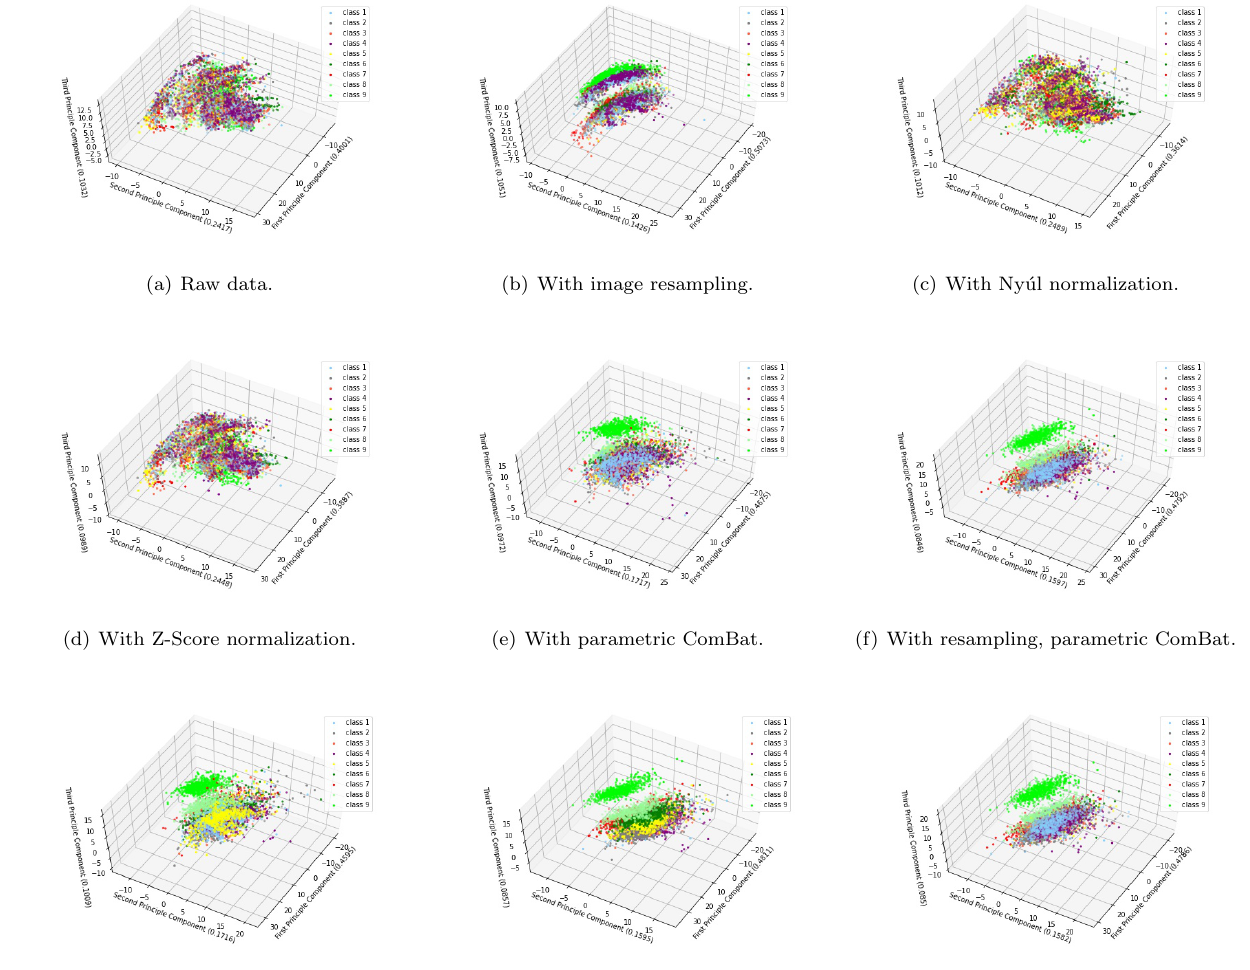
Figure 10. Visualize the first three principal components of PCA of the homogeneous phantom data in a 3D plane, with different preprocessing and harmonization methods. Here “class 1” to “class 9” correspond to the nine homogeneous phantom tubes. The subfigures show the two example features acquired from MRI images ( a ) without applying any preprocessing and harmonization methods (raw data), ( b ) with only applying the image resampling, ( c ) with only applying the Nyúl normalization, ( d ) with only applying the Z-Score normalization, ( e ) with only applying the parametric ComBat, ( f ) with applying the resampling and parametric ComBat, ( g ) with applying the Nyúl normalization and parametric ComBat, ( h ) with applying the resampling, Nyúl normalization and parametric ComBat, and ( i ) with applying the resampling, Z-Score and parametric ComBat. Note that the identifiability between different classes is better visible in the animation form, see https://github.com/Yingping-LI/MRI_Radiomics/blob/main/preprocessing_and_harmonization.md, accessed on 11 June